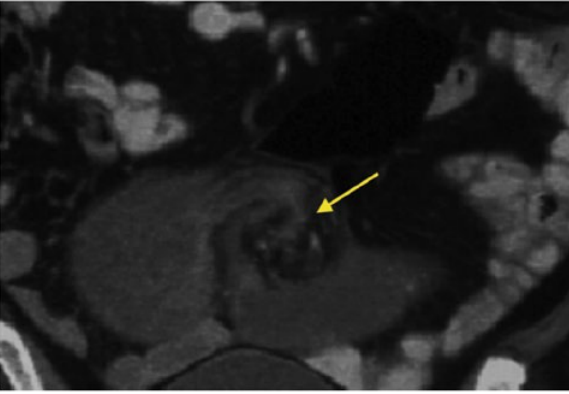
Figure 7: Axial CT appearance of the whirl sign (arrow) due to convergence of vessels around a fixed point of obstruction